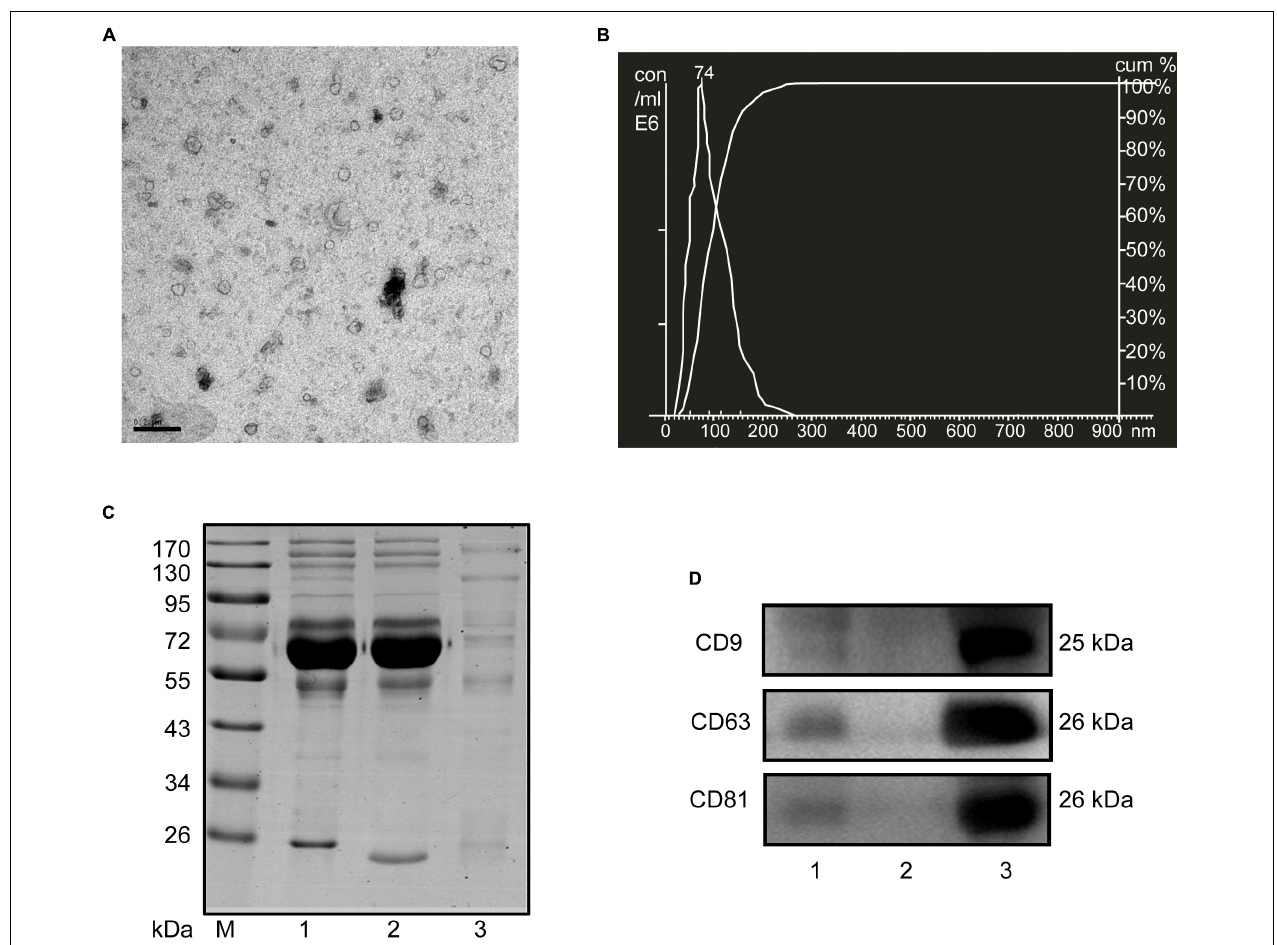
FIGURE 2 | Characterization of sEVs isolated from mouse serum. (A) The TEM image depicts the spherical morphology of the isolated sEVs, bar = 200 nm. (B) NTA analysis plot illustrates the size distribution and concentration of the sEVs isolated mouse serum. (C) Proteins from serum, sEVs-depleted serum, and sEVs were separated by SDS-PAGE and stained by Coomassie blue. 40 µ g proteins from serum and sEVs depleted serum were loaded. The amount of sEVs protein was adjusted by the serum volume corresponding to 40 µ g serum protein. (D) The expression of CD9, CD81, and CD63, markers of exosomes, was detected by western blotting. Lane 1: total serum; lane 2: sEVs-depleted serum; lane 3: serum